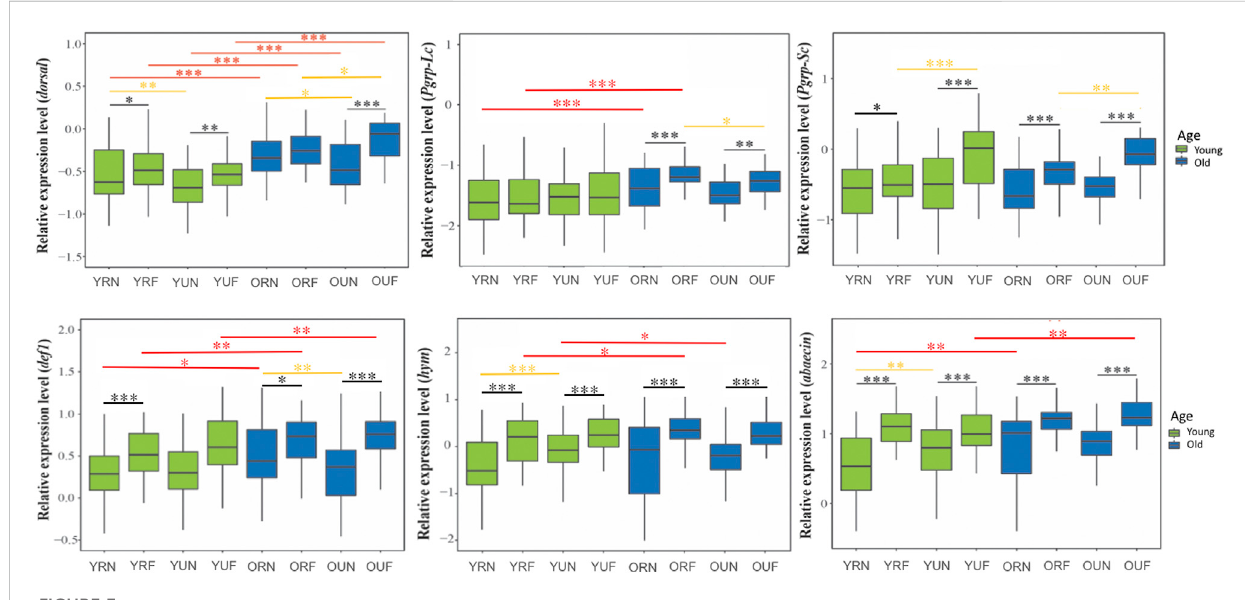
FIGURE 3 Expression of immune genes involved in the humoral immune response and the regulatory gene dorsal . Sample notation is as in Figure 2. Black, yellow and red asterisks illustrate signi fi cant differences between behavioral, nutritional, and age groups. * p < 0.05; ** p < 0.01. *** p <